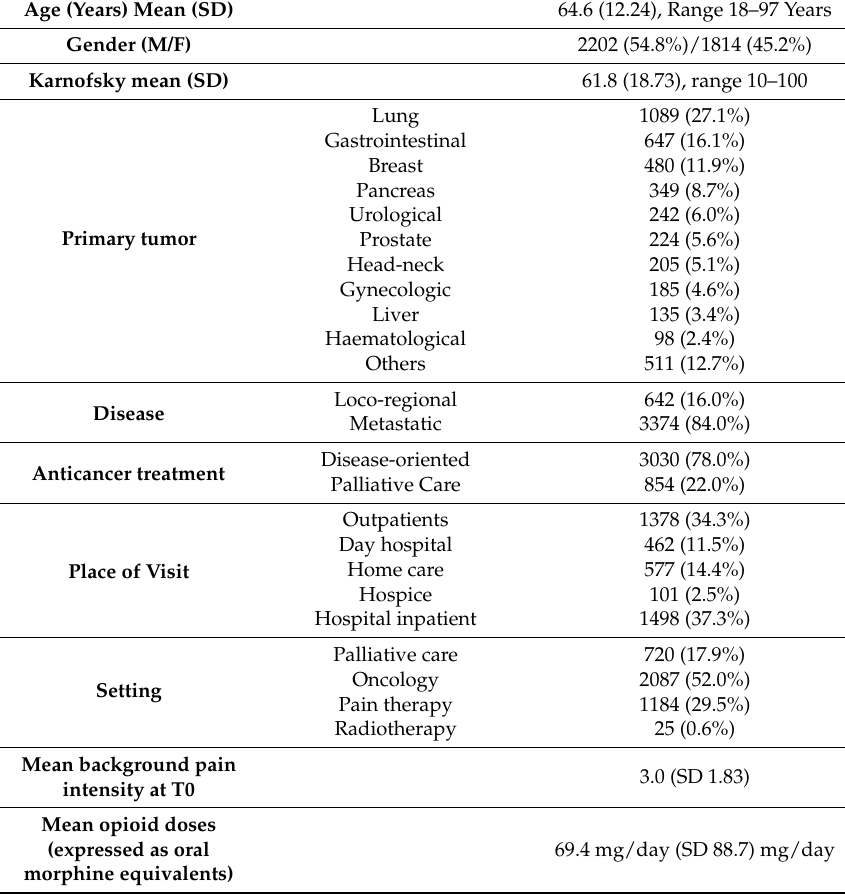
Table 1. Characteristics of